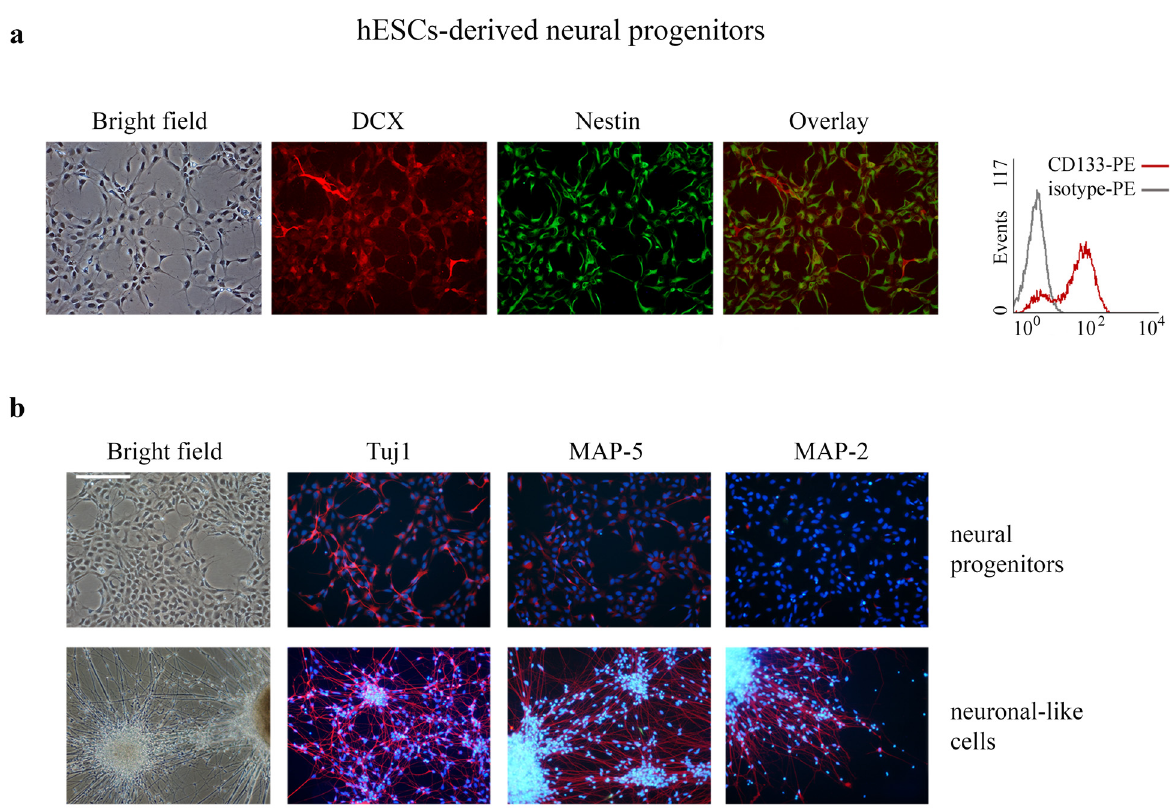
Fig 1. hESCs-derived NP and differentiated-neuronal-like cells phenotypic characterization. (a) Representative images of NP stained with primary antibodies against nestin and DCX (left panel). Representative flow cytometry histograms overlays of H9 hESCs-derived NP are shown to visualize CD133 expression relative to isotype control (right panel) (b) Representative images of NP and differentiated neuronal-like counterparts stained with primary antibodies against MAP-2, MAP-5 and Tuj1. The nuclei were counterstained with DAPI. The scale bars represent 100 μ